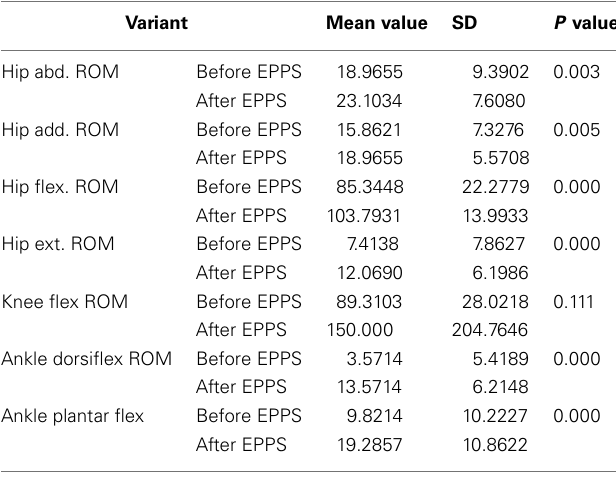
Table 2 | The comparison between mean ROM of joints in Lower limbs before and after receiving the EPPS protocol in veterans used the EPPS optimally.